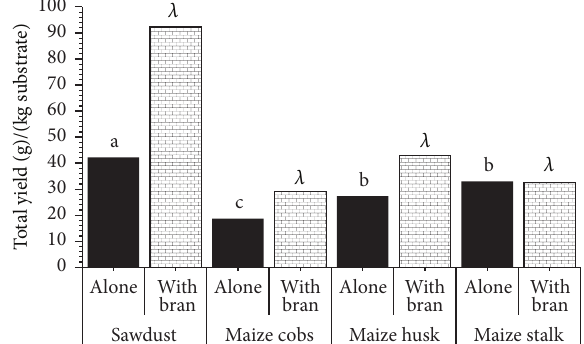
Figure 4: The effect of substrates on the yield of oyster mushrooms in a crop. (1) Bars with the same Arabic letter for substrate material alone or same Greek letter for bran fortified substrates are not significantly different 𝑃 < 0.001 . (2) Substrates with bran contain 8.4% rice